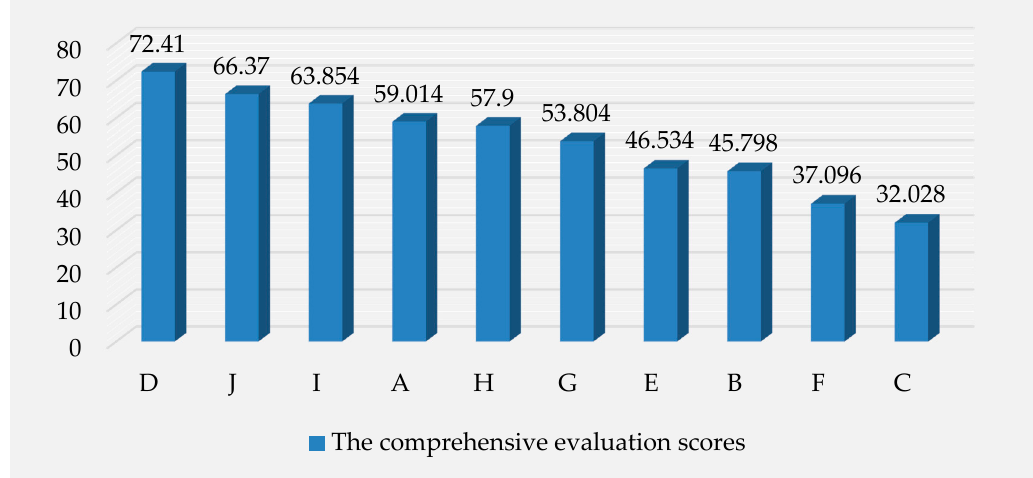
Figure 6. Evaluation scores of energy saving and emission reduction effects of the 5 electricity retailers.